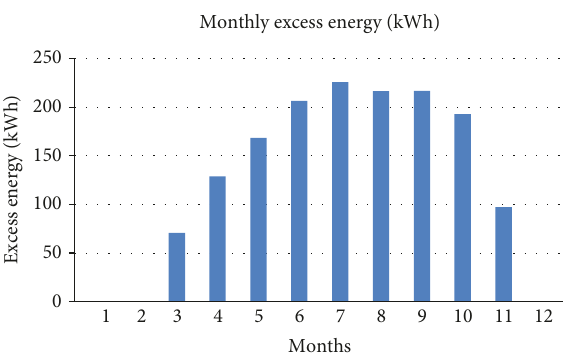
Figure 9: Monthly excess PV